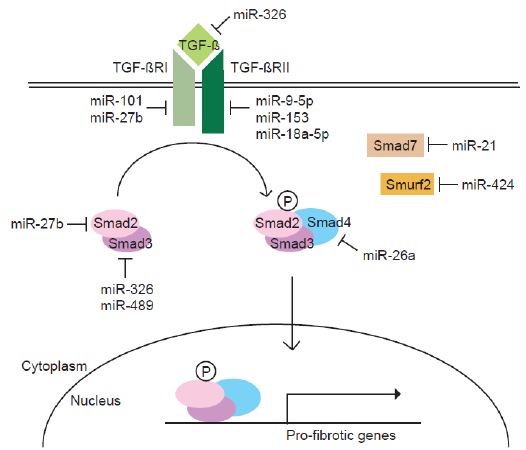
Figure 1. Regulation of the TGF- β signaling pathway by miRNAs. In response to TGF- β signal, the expression of a cohort of miRNAs is modulated. Each miRNA is implicated in the process of pulmonary fibrosis by targeting components of the TGF- β signaling pathway. Normal arrows represent activation and nuclear translocation of Smads. T-bar arrows represent inhibition of indicated